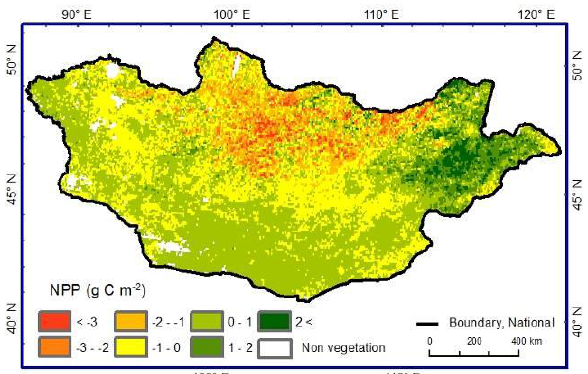
Figure 5. NPP changes during 1982-2015 (g C/m 2 /year) 3.3